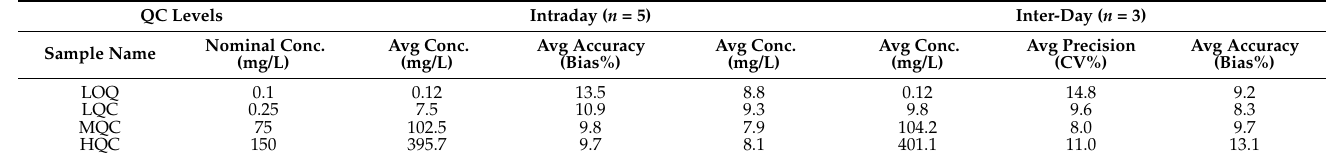
Table 3. Intra-day and inter-day average (avg) precision and accuracy assessed at four concentration levels (LOQ, LQC, MQC, and HQC) five times (intra-day) in three different analytical runs (inter-day).